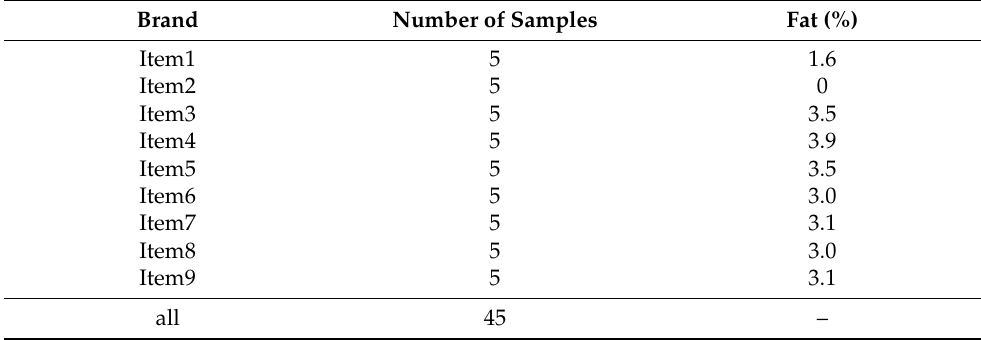
Table 2. The fat contents of the milk samples.